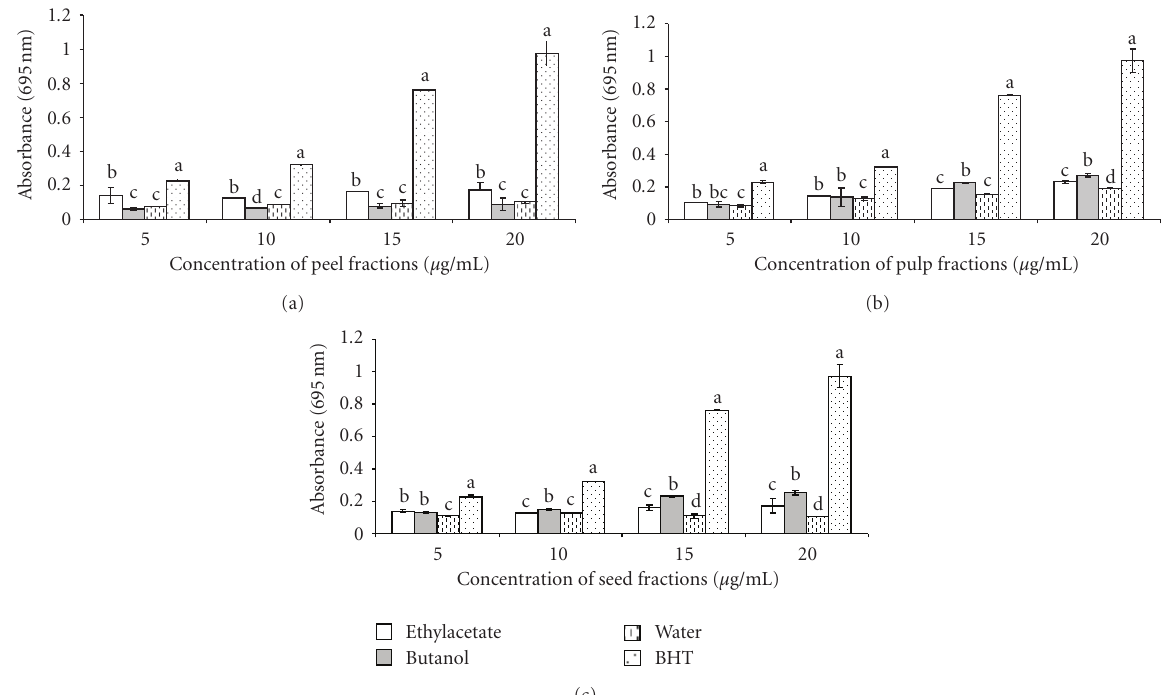
Figure 3: Total antioxidant capacity of Canarium odontophyllum peel fractions (a), pulp fractions (b), and seed fractions (c). Higher absorbance value indicates higher antioxidant activity. Di ff erent letters above the bars for the same concentration indicate statistically significant di ff erences at P < .